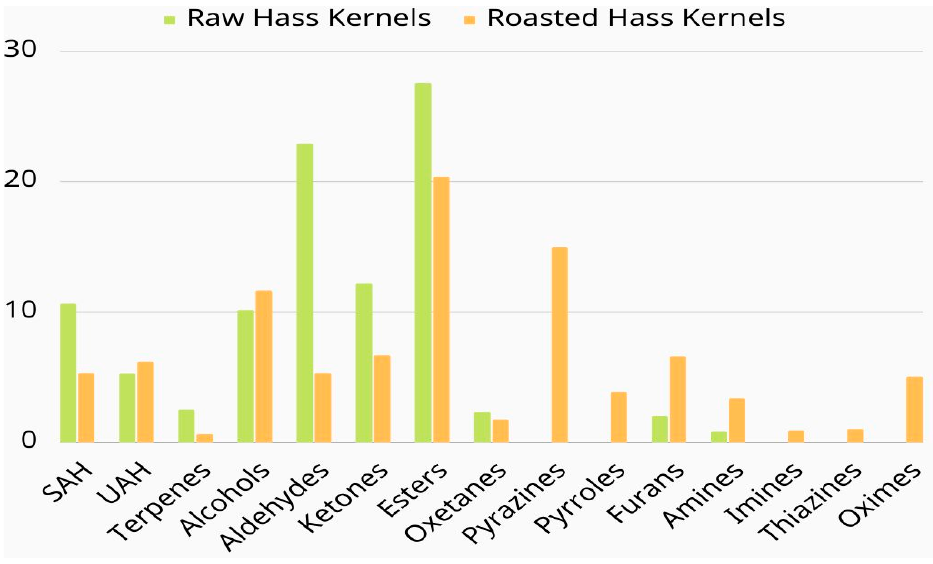
Figure 3. The total percentages of the chemical classes found in the GC-MS profile of raw and roasted avocado kernels.